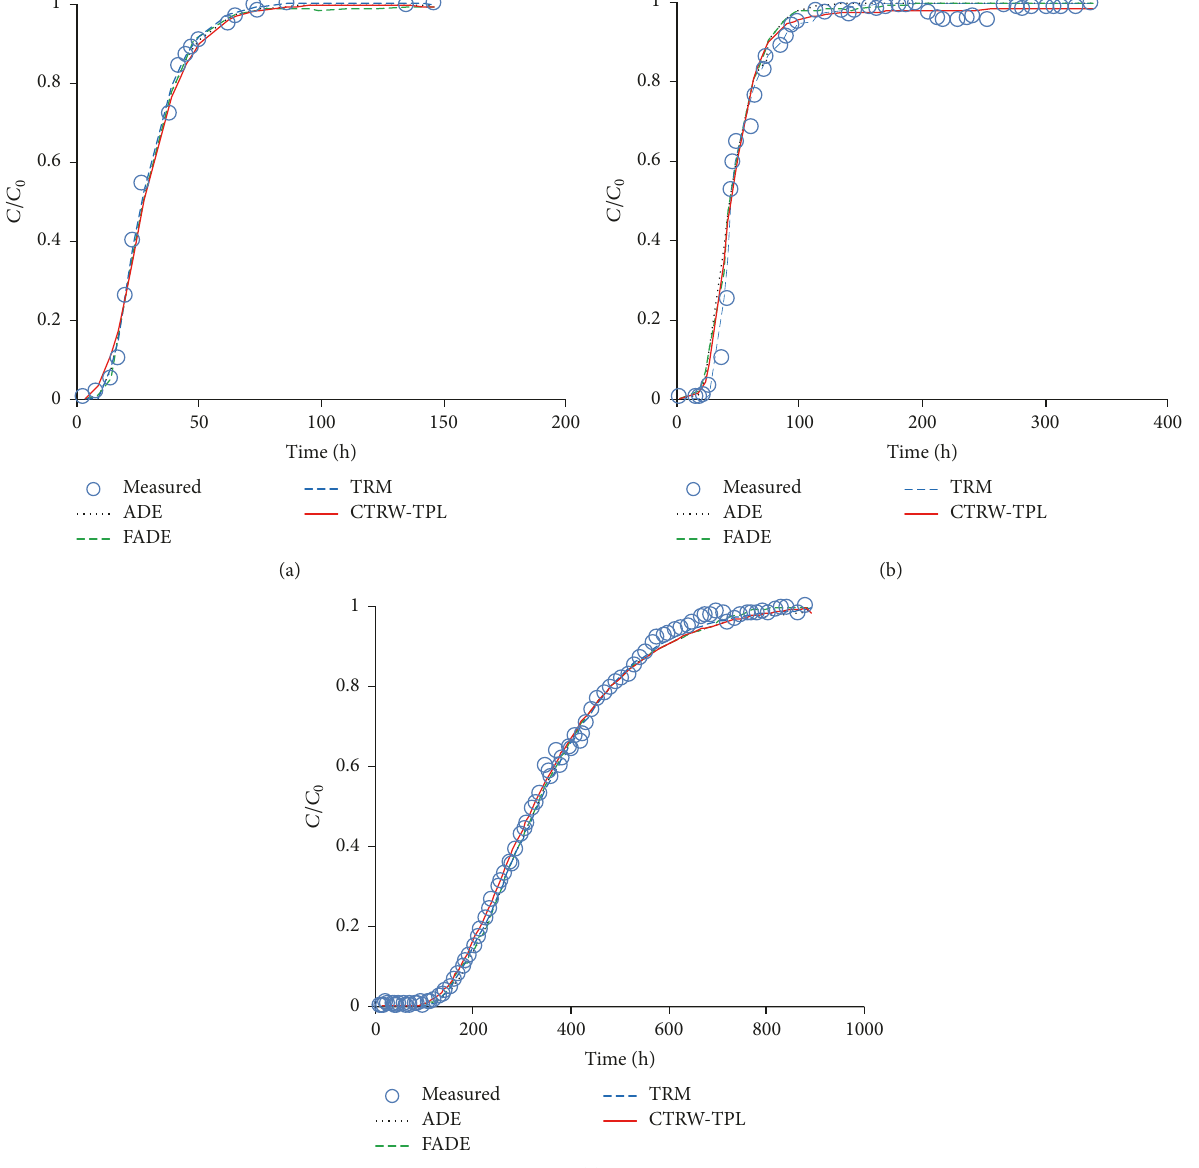
models with corresponding 𝑅 2 values all over 0.98 and the small values of the RMSE (see Table S1 in Supplementary